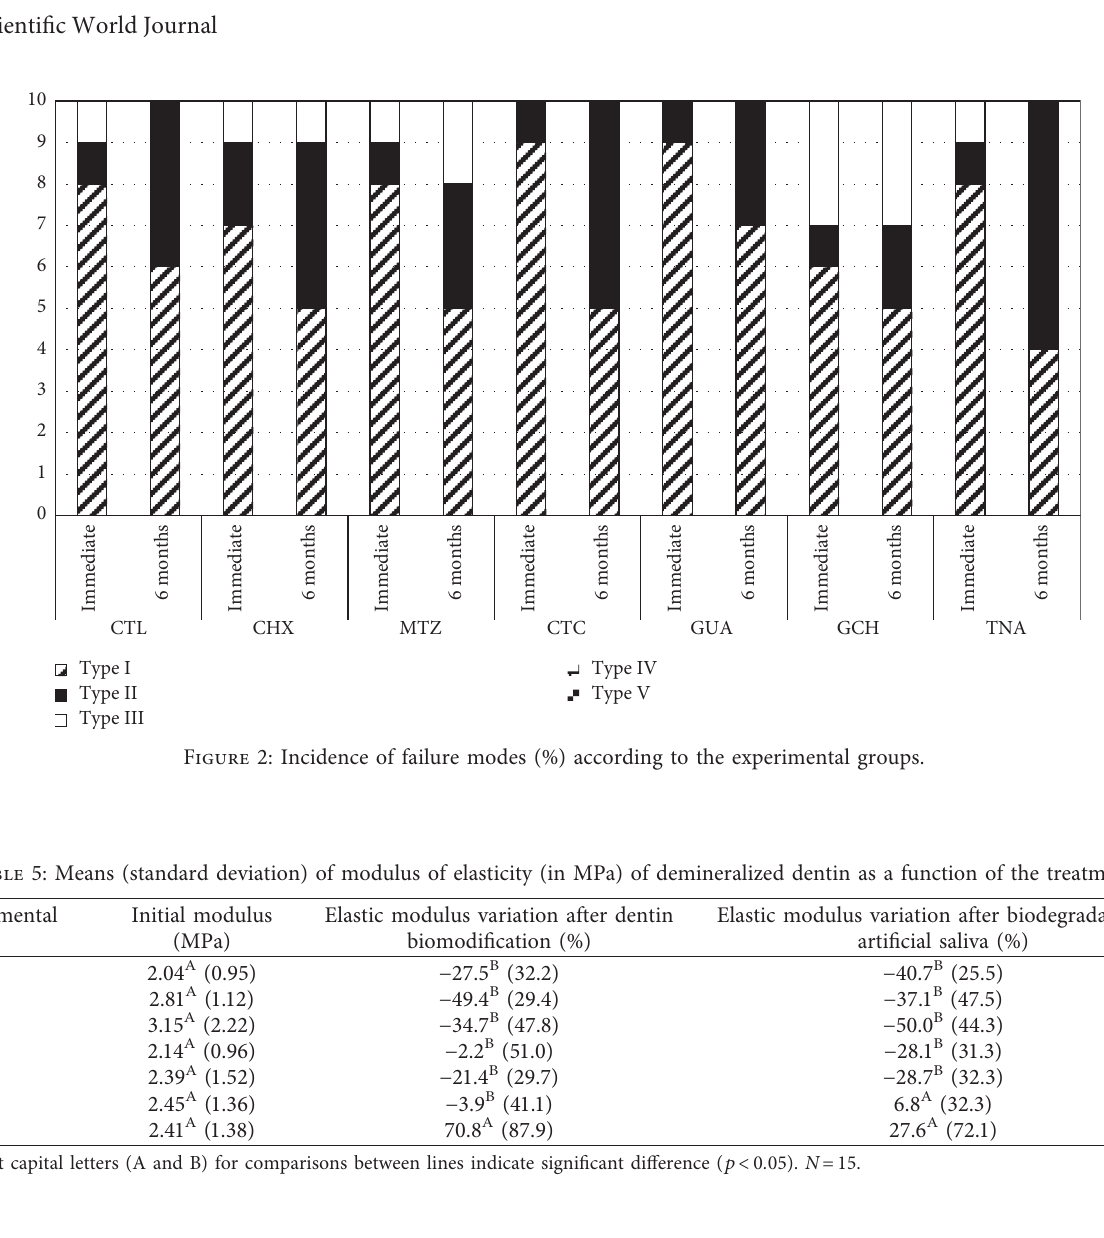
Table 6: Mean (SD) of mass variation (%) of dentin specimens as a function of the treatment. Experimental groups Mass variation (%) after dentin